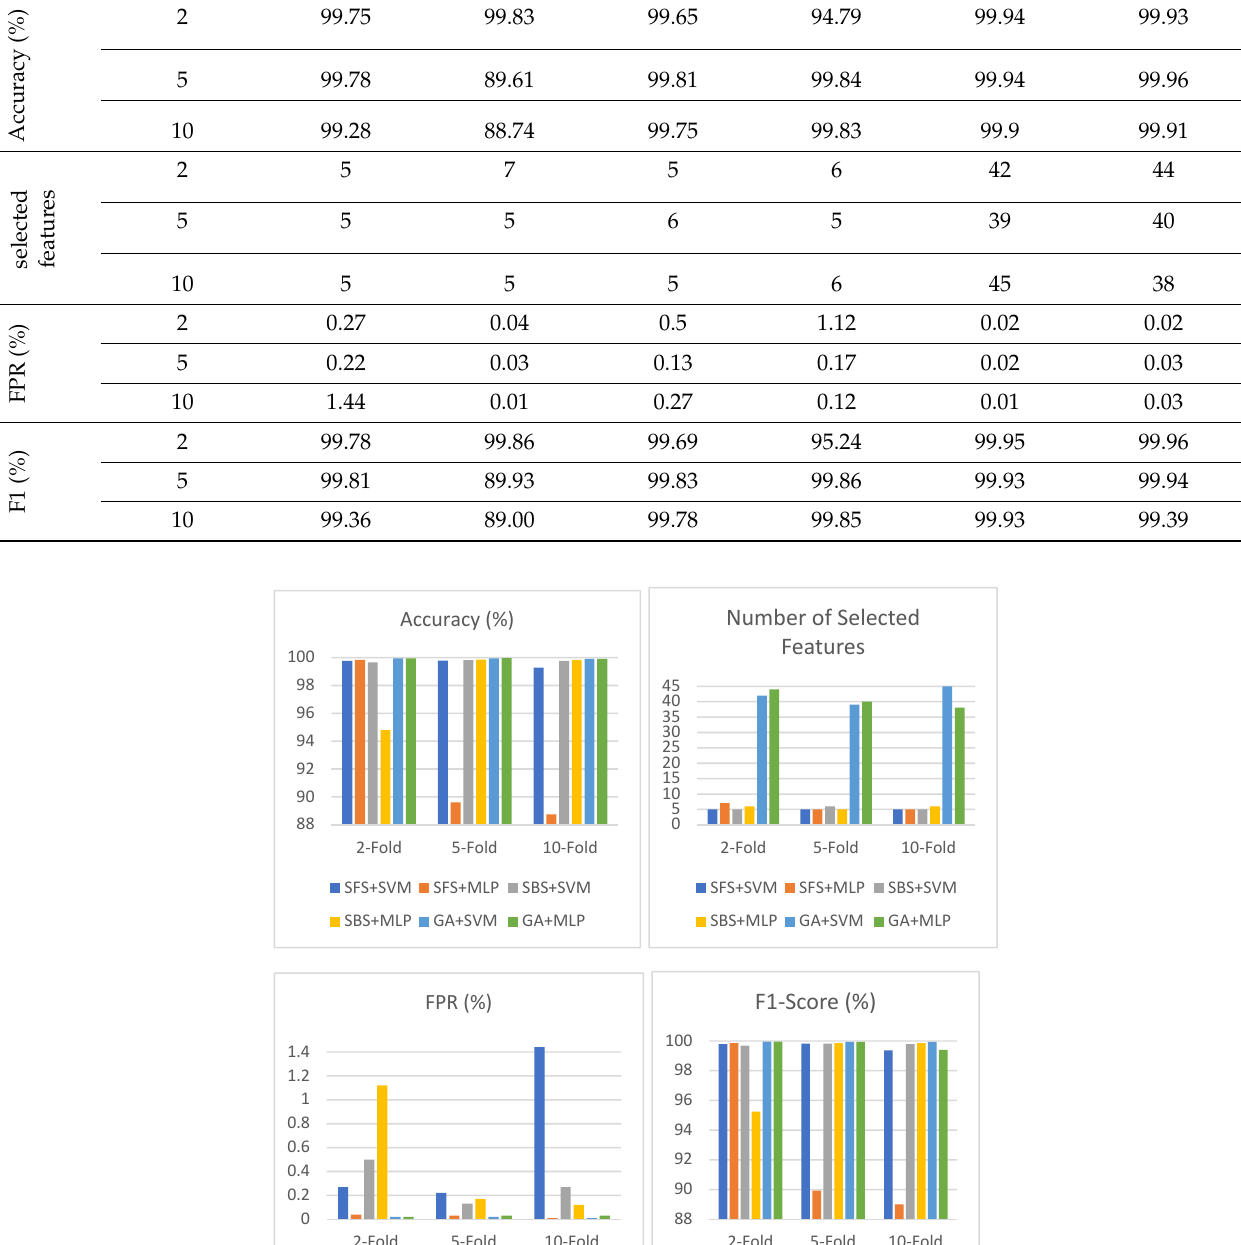
Table 7. Performance of SFS, SBS, and GA using objective function based on accuracy and number of selected features in CIC-IDS-2017. Metric